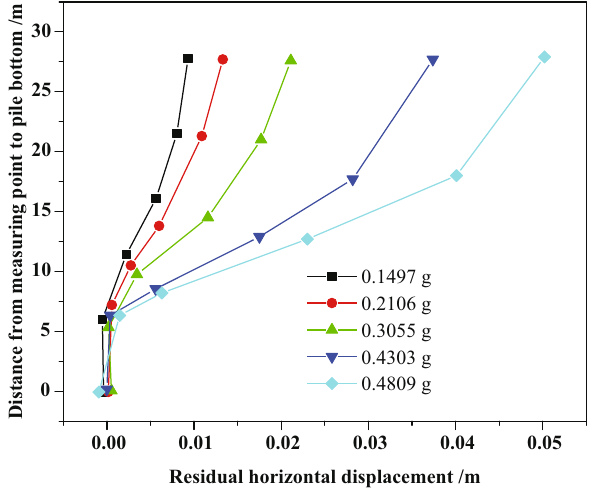
Figure 3: Residual horizontal displacements of P2